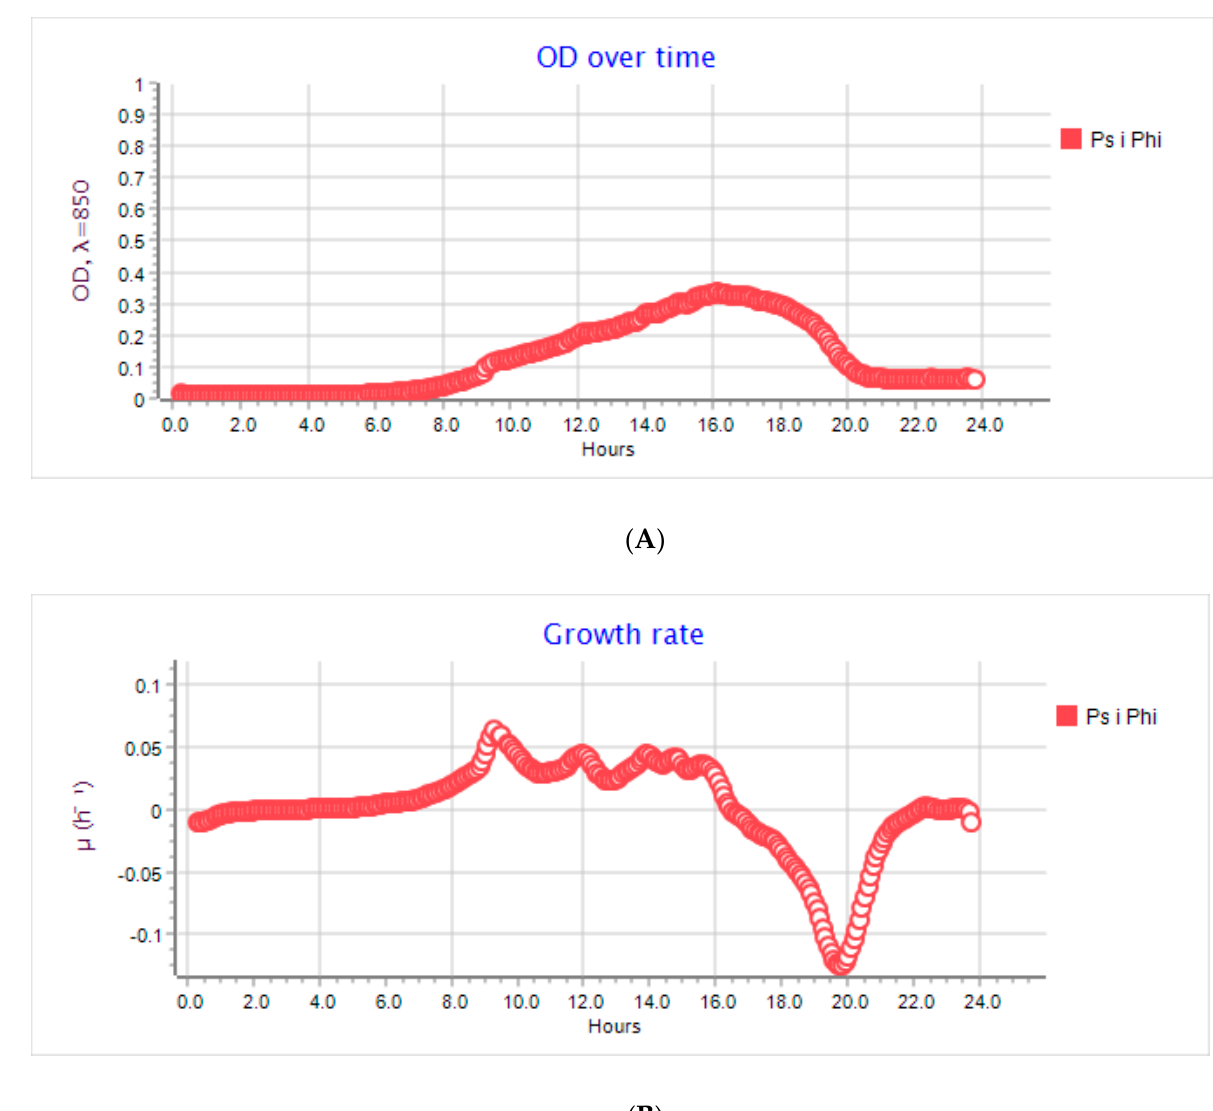
Figure 4. ( A ) OD over time for P. syringe after 48 h of incubation. Incubation devoid of phi 6 phages; OD—0.2. ( B ) The growth rate of P. syringe after 48 h of incubation. Incubation devoid of phi 6 phages; OD—0.2.